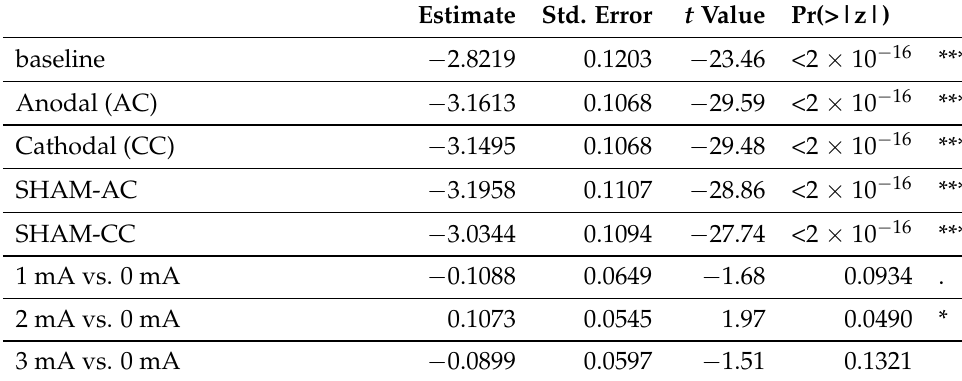
Table A1. Mixed model—Fixed effects